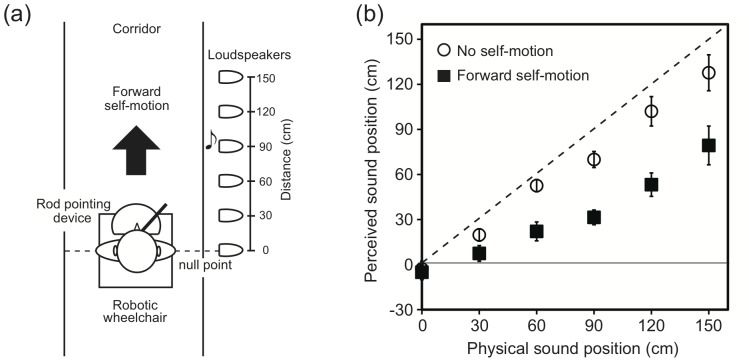
Schematic diagram of experimental setup used in Experiment 3 (a) and Effect of acceleration on auditory egocentric localization observed in Experiment 3 (b).The rod-pointing device was set very close to the participant’s body in the mid-sagittal plane. The participants were transported forward at 0.4 m/s2 of acceleration. The black squares represent forward self-motion, whereas the white circles represent no self-motion. The dashed line indicates the ideal performance. Error bars denote standard errors.